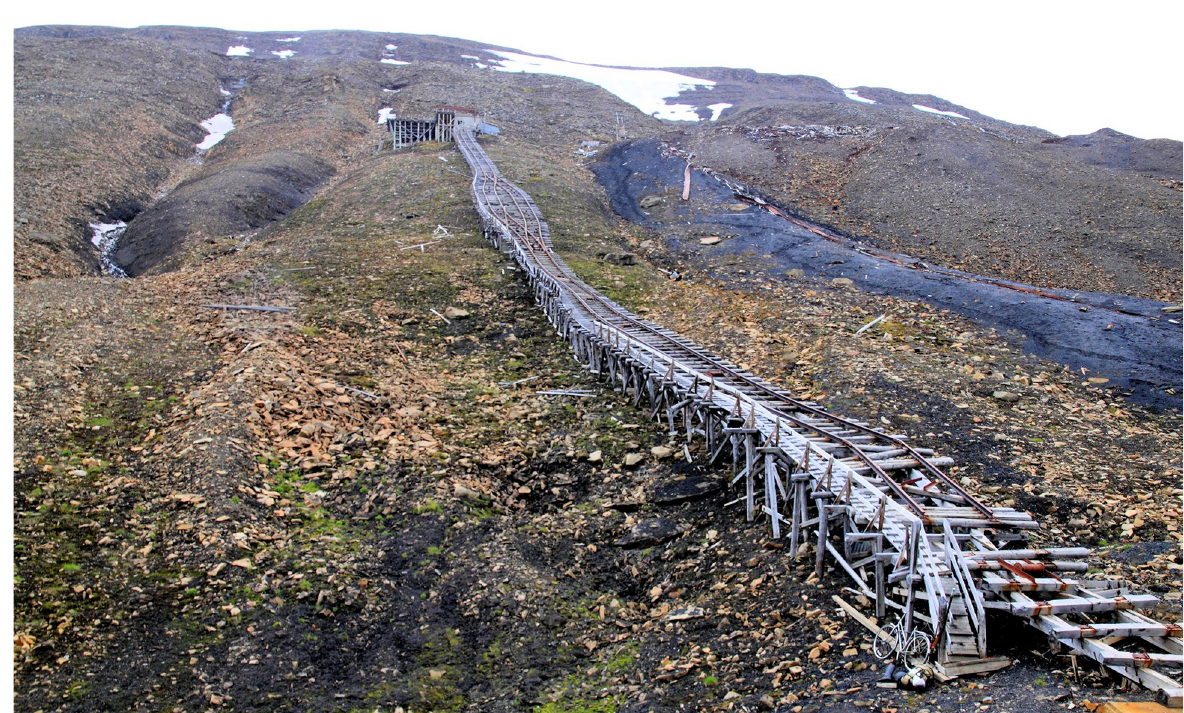
Fig. 3. Abandoned coal mine from the 20 th century in Endalen near Longyearbyen (Photo: W.Ziaja